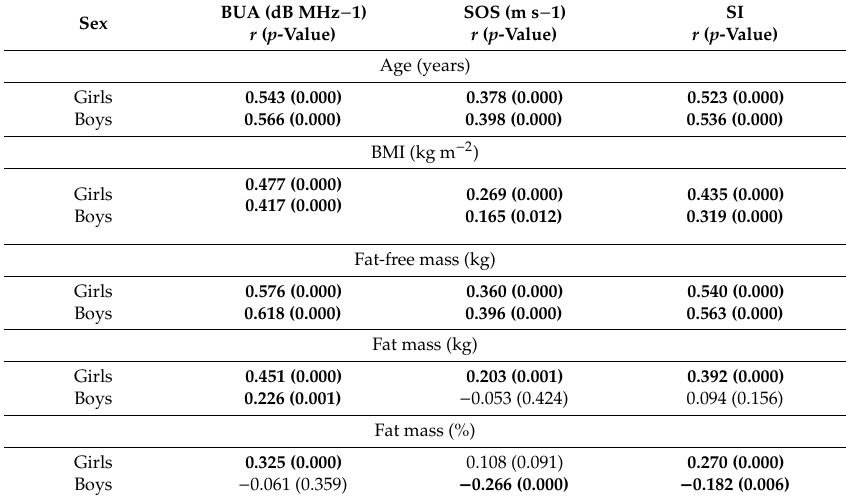
Table 5. Correlation coe ffi cients ( r ) between bone parameters and several variables in girls ( n = 248) and boys ( n =